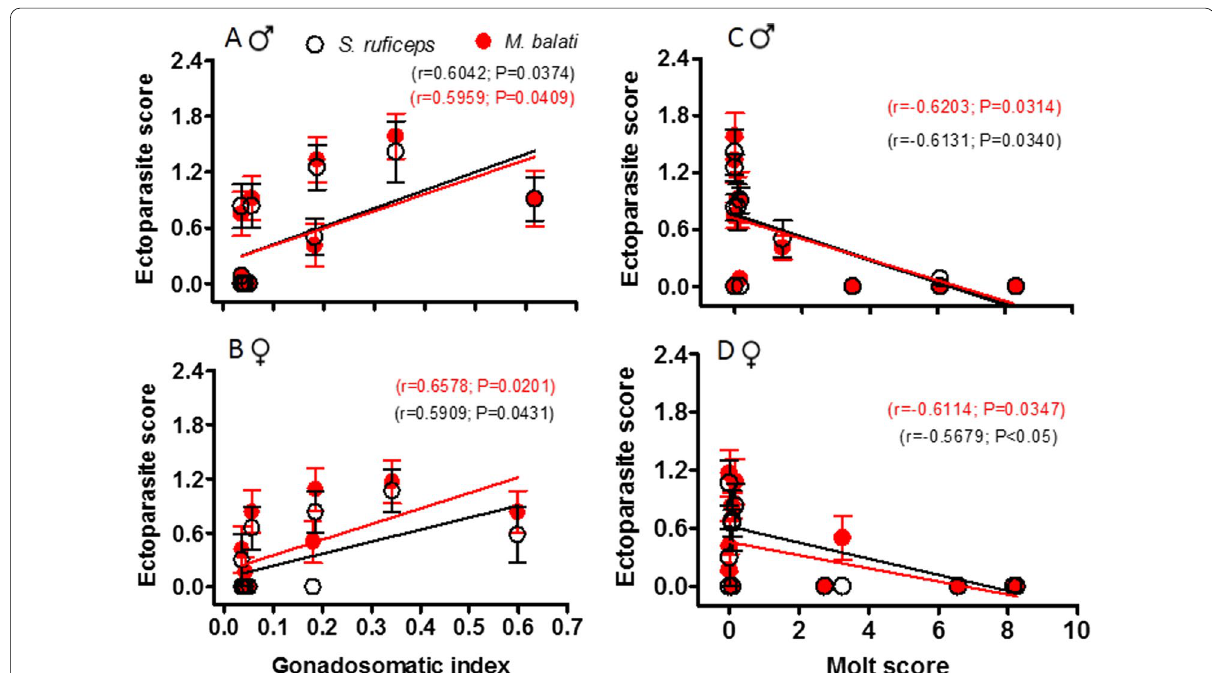
Fig. 3 Correlation of ectoparasite scores of Myrsidea balati and Sturnidoecus ruficeps with gonadosomatic ( A , B ) and with molt score ( C , D ) in both the sexes of tree sparrow (TS)